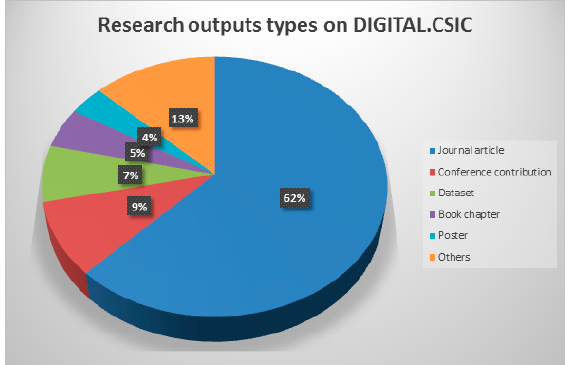
Figure 2. Distribution of contents on DIGITAL.CSIC by resource type. Source: DIGITAL.CSIC.